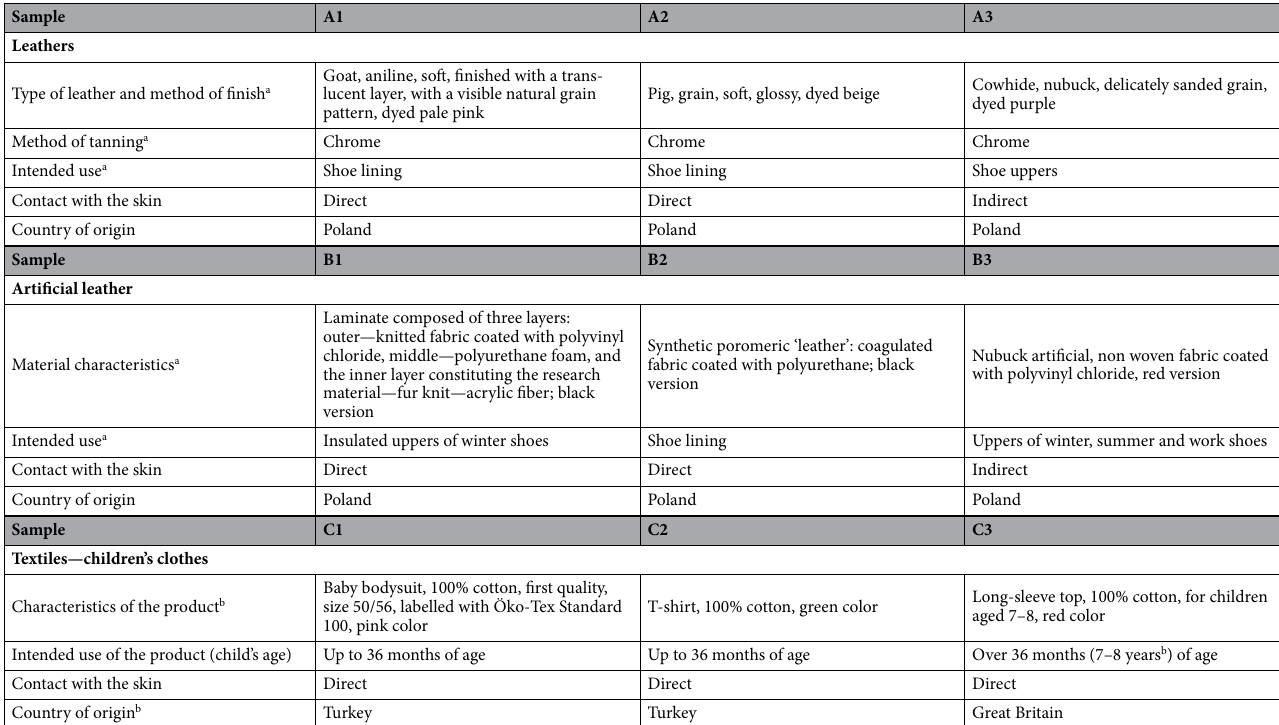
Table 1. Leathers, artificial leathers, and textiles. Characteristics of the tested material. Source: Author’s own research. a According to manufacturer’s declaration. b According to the information on the tag.